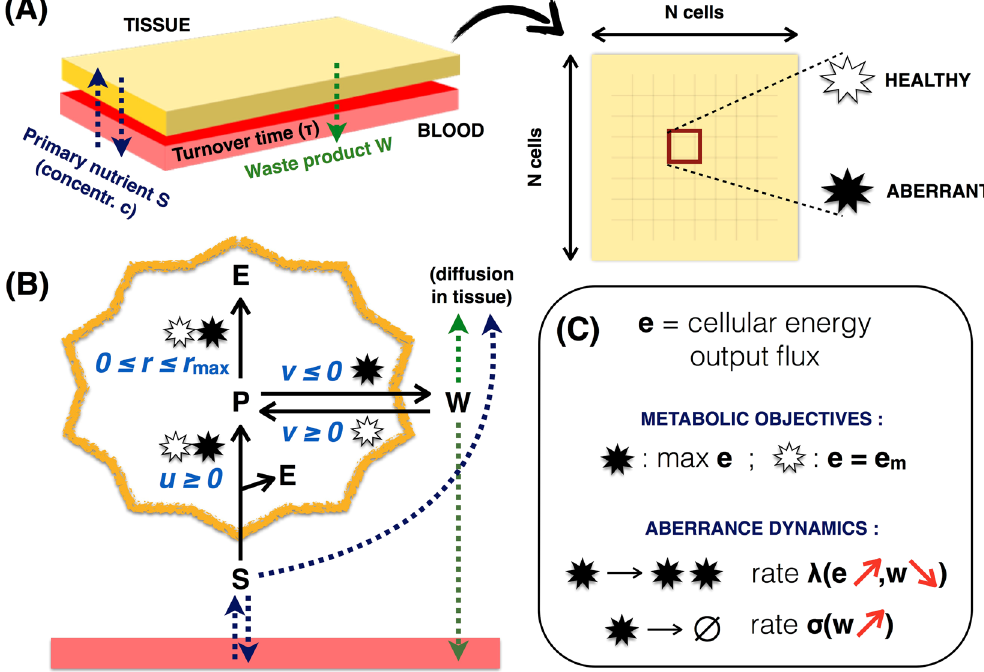
Figure 1. Scheme of main processes considered in the model. ( A ) A single layer of cells arranged in an N × N square lattice (the “tissue”) is in contact with a reservoir (the “blood”), where a primary carbon source S is available at concentration c . S can diffuse through the blood-tissue barrier and inside the tissue. Each tissue site is occupied by a cell that can be either “healthy” or “aberrant”. ( B ) Each cell can import and process S generating energy E (rate u , yield Y u ) and a precursor P and further process the precursor into E (rate r , yield Y r > Y u ). Because r is capped, aberrant cells can process the excess precursor into a waste product W , which is excreted and can diffuse across the tissue and into the blood. Healthy cells instead operate far from saturating r and can re-cycle W to generate more P . ( C ) Aberrant cells have a larger capacity to import S and aim at maximizing their energy output flux e . e m instead represents the maintenance energy output of healthy cells. Cells are sensitive to the local concentrations of W (denoted by w ) and S (denoted by s ). In particular, aberrant cells replicate at a rate λ that is an increasing function of their energy output and a decreasing function of w . Likewise, they can die (and be replaced by a healthy cell) at a rate σ that is an increasing function of w . The primary nutrient import flux is instead a function of the local level of S experienced by